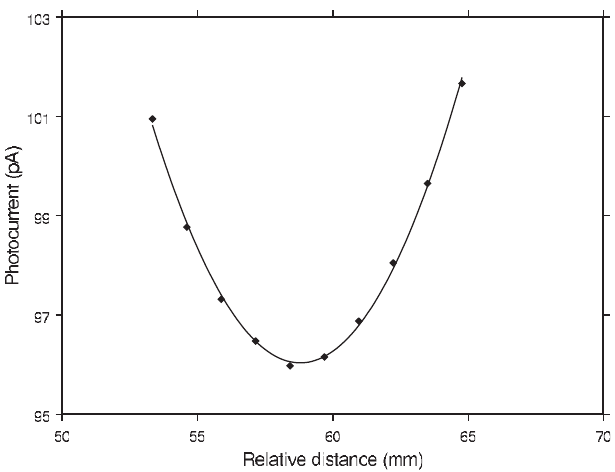
FIG. 7. Measured photocurrent as a function of vertical dis- placement in the center minimum region by FR1 with 380 MeV SURF current. The line is the best fit curve to a quadratic polynomial for the determination of the on-orbit position.